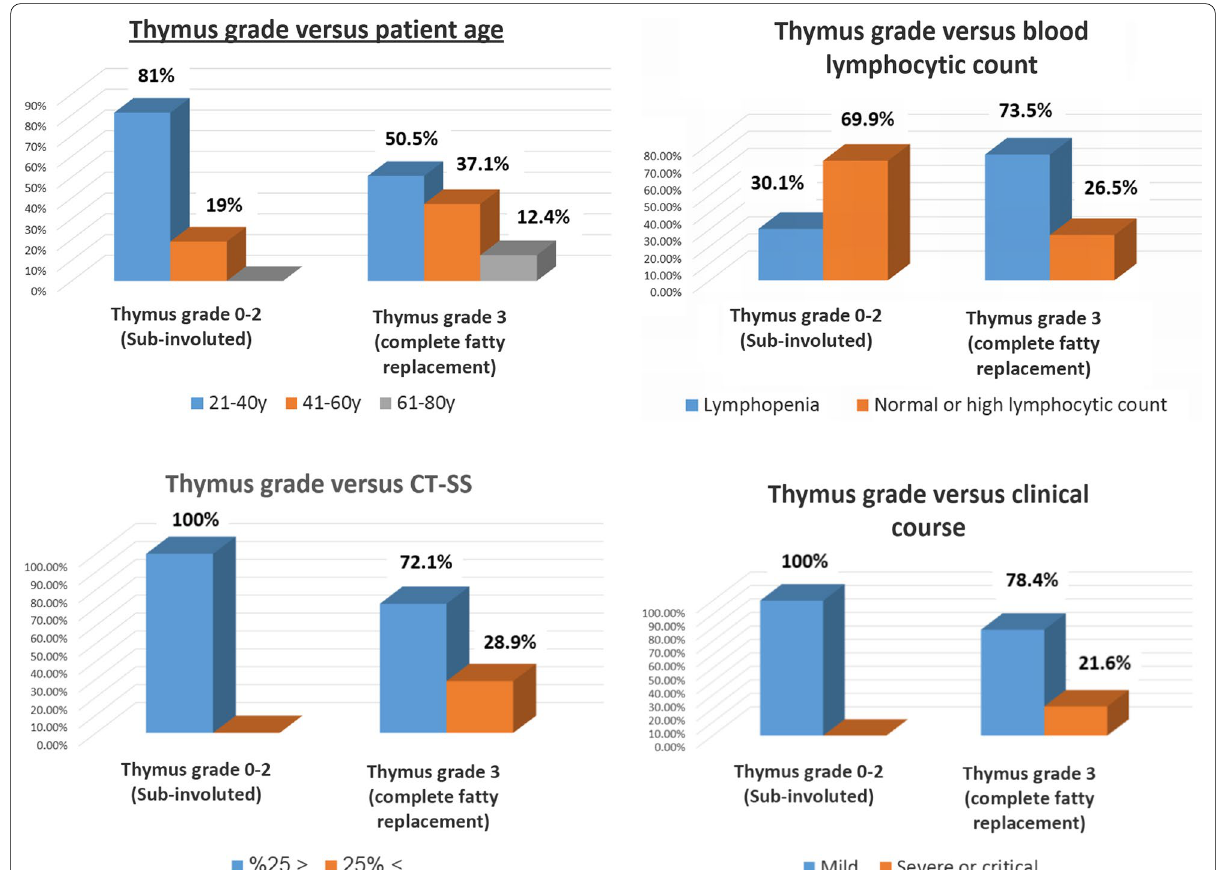
Fig. 3 Illustrative isolated charts to show the relation between thymic CT-grading and patients’ age, blood lymphocytic count, CT-SS as well as the clinical